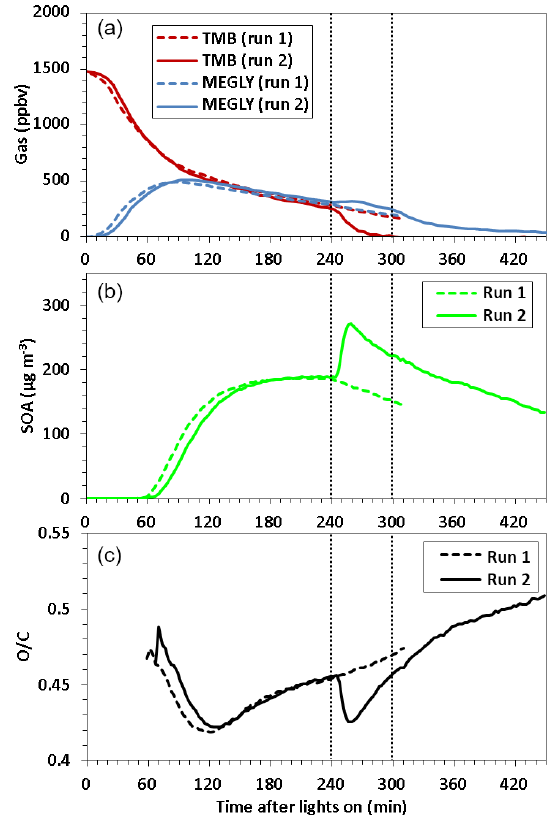
Figure 1. Time series of (a) TMB and methylglyoxal (MEGLY) concentrations observed by FT-IR, (b) SOA mass concentration ob- served by AMS, and (c) O / C ratio observed for organic aerosol by AMS during normal photooxidation (run 1) and aging experiments (run 2). Methyl nitrite was added in run 2 at the irradiation times indicated by vertical dotted straight